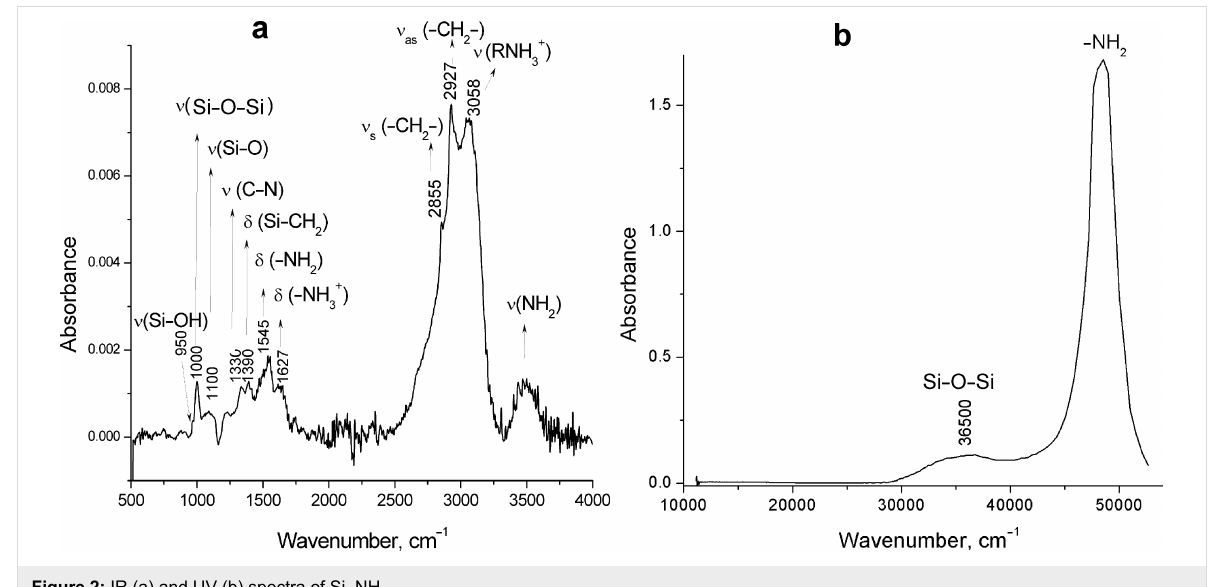
Figure 2: IR (a) and UV (b) spectra of Si–NH 2